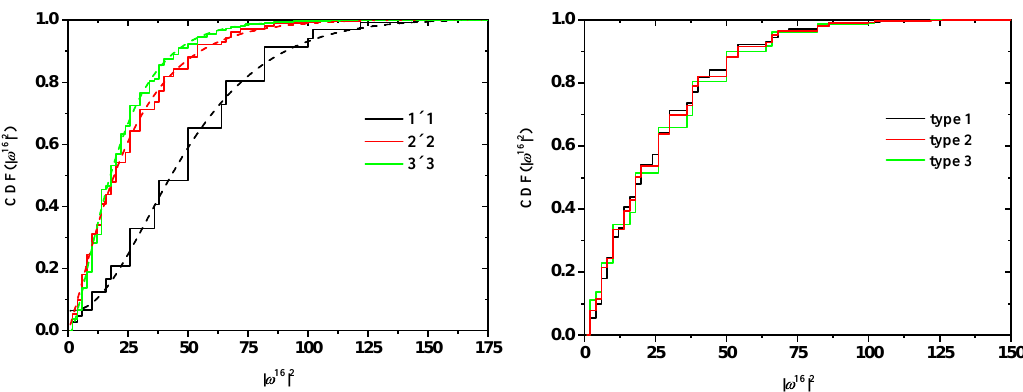
(cid:12) (cid:12) 2 for SAWs of fixed length (cid:12) ω 16 (cid:12)